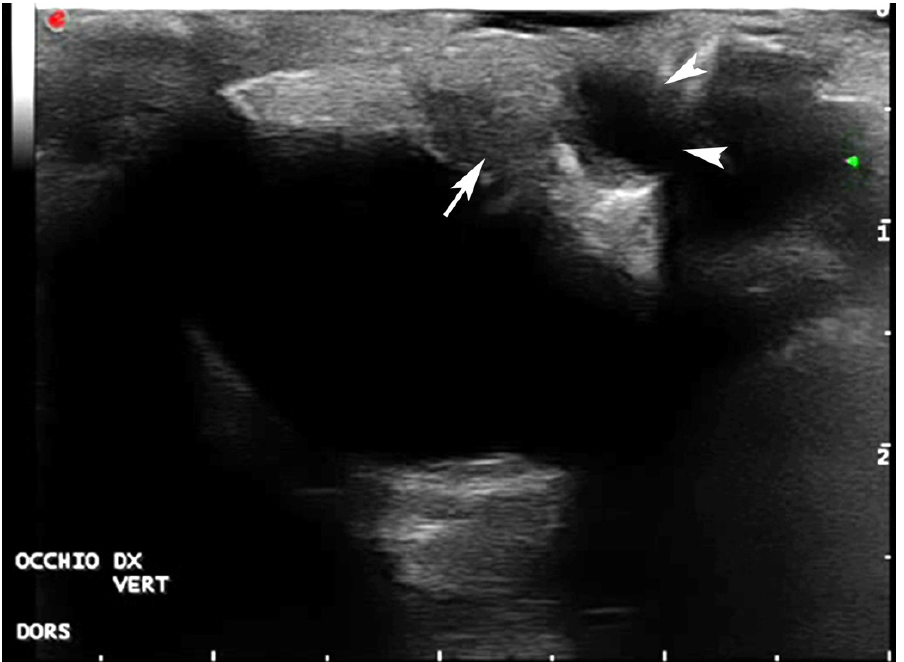
Figure 3. Ultrasonography of the right eye, vertical lateral-parasagittal scan: adhesion between the eyelid and cornea is seen (arrow). A fluid collection in the dorsal conjunctival space is also present (arrowheads).